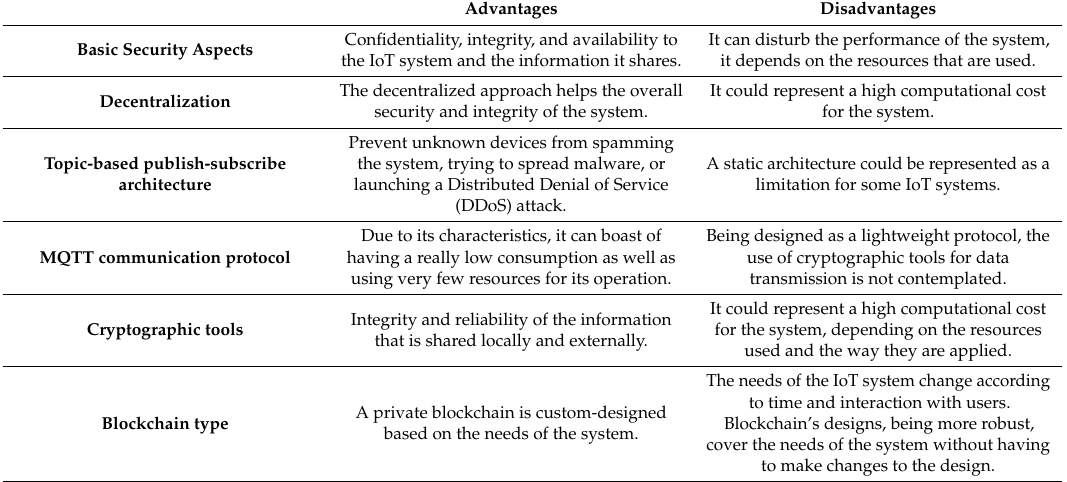
Table 3. Characteristics, pros, and cons of each related scheme.